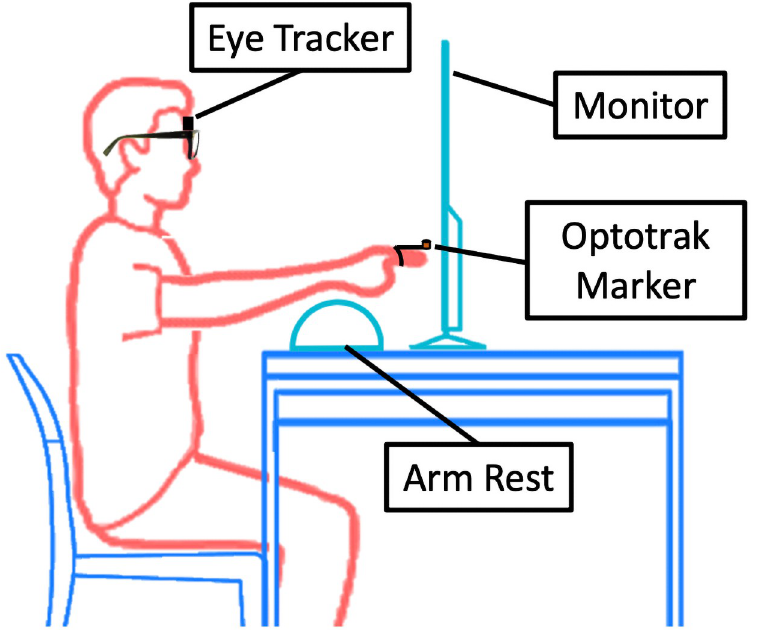
Fig 2. Experimental setup. Each participant was seated at a table within reach of a monitor, which displayed task targets. Eye movements were recorded with a commercial head-mounted eye tracker. A motion capture marker was affixed to the participant’s finger to record hand movements. The participant was permitted to use the arm rest between reaches to reduce fatigue.